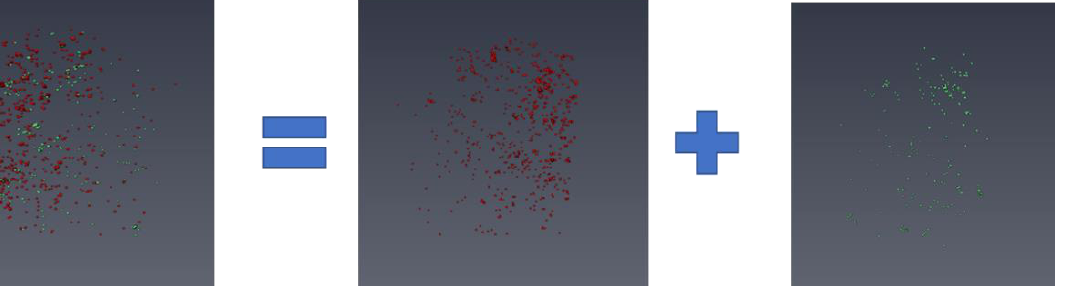
Figure 21. Three-dimensional schematic diagram of the Y56 – 19 core after the second water flooding (red is the distribution of the crude oil and yellow is the injected CO 2 ).